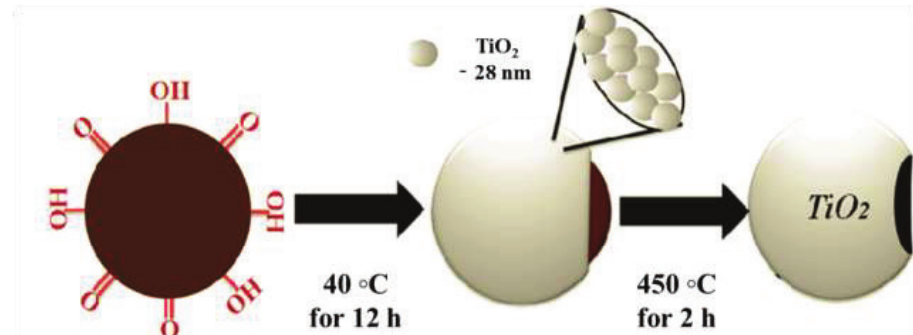
Fig. 1. Scheme of three phases of TOHS, illustrating the growth of nanostructured fi le over a CS and the removal of